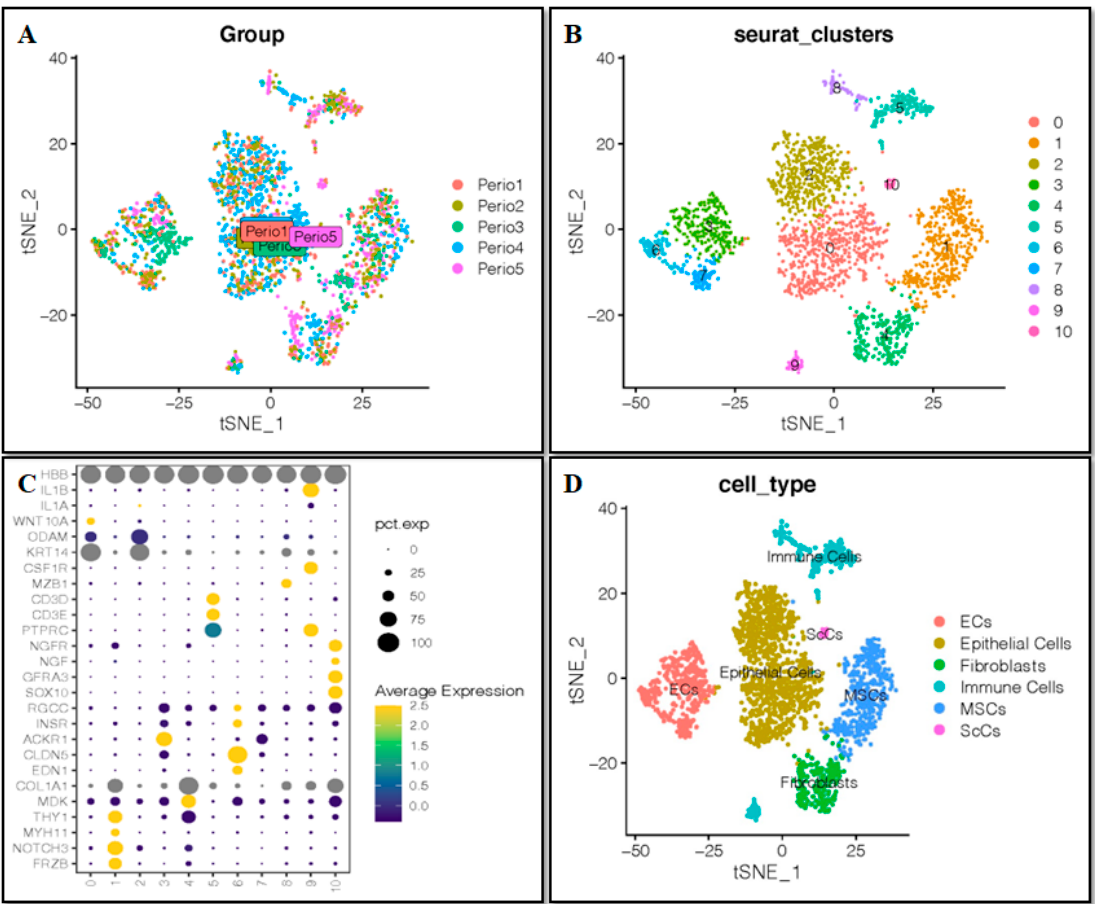
Figure 1. Single-cell analysis and cell annotation. ( A ) Sample-to-batch effect. ( B ) 11 clusters of cells were identified. ( C ) Marker gene expression in each cluster. ( D ) Cells are annotated into six cell types.